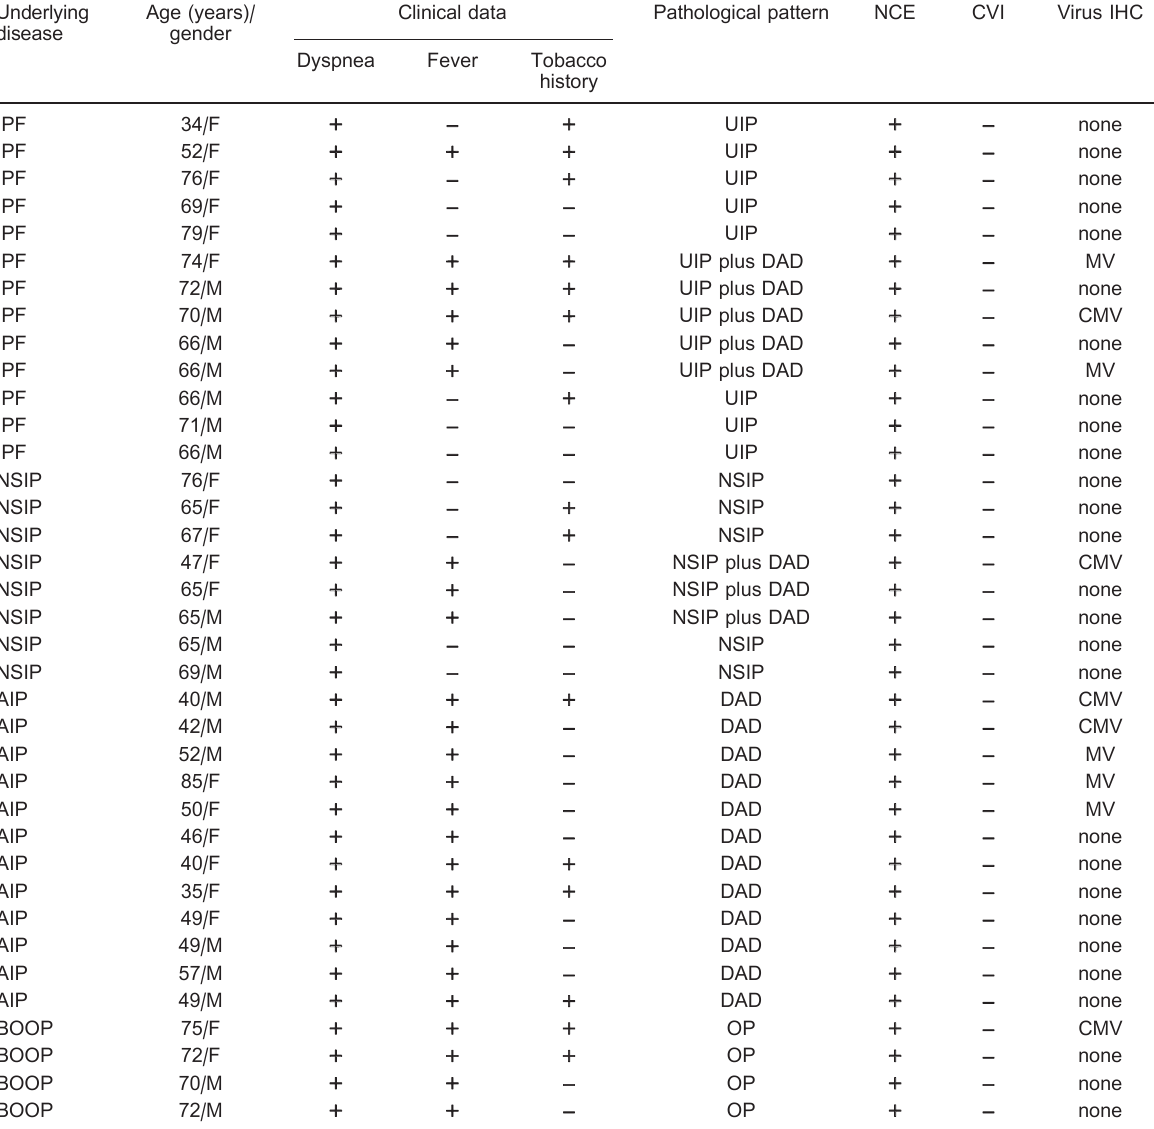
Table 1. Clinical data of patients with idiopathic pulmonary fibrosis, nonspecific interstitial pneumonia, acute interstitial pneumonia, and bronchiolitis obliterans organizing pneumonia. Underlying